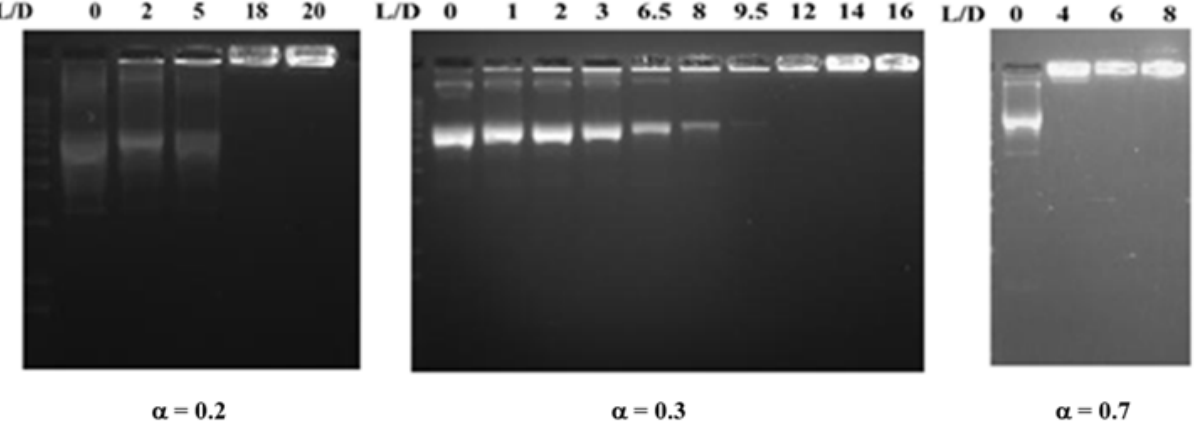
Figure 6. Electrophoretic mobility shift assay on an agarose gel (1%) for DOPE/12NBr/pDNA lipoplexes at different α values. Experiments were run in TAE buffer (40 mM tris-acetate, 1 mM EDTA) and stained with Red Safe. Electrophoresis was performed at 90 V until completion.